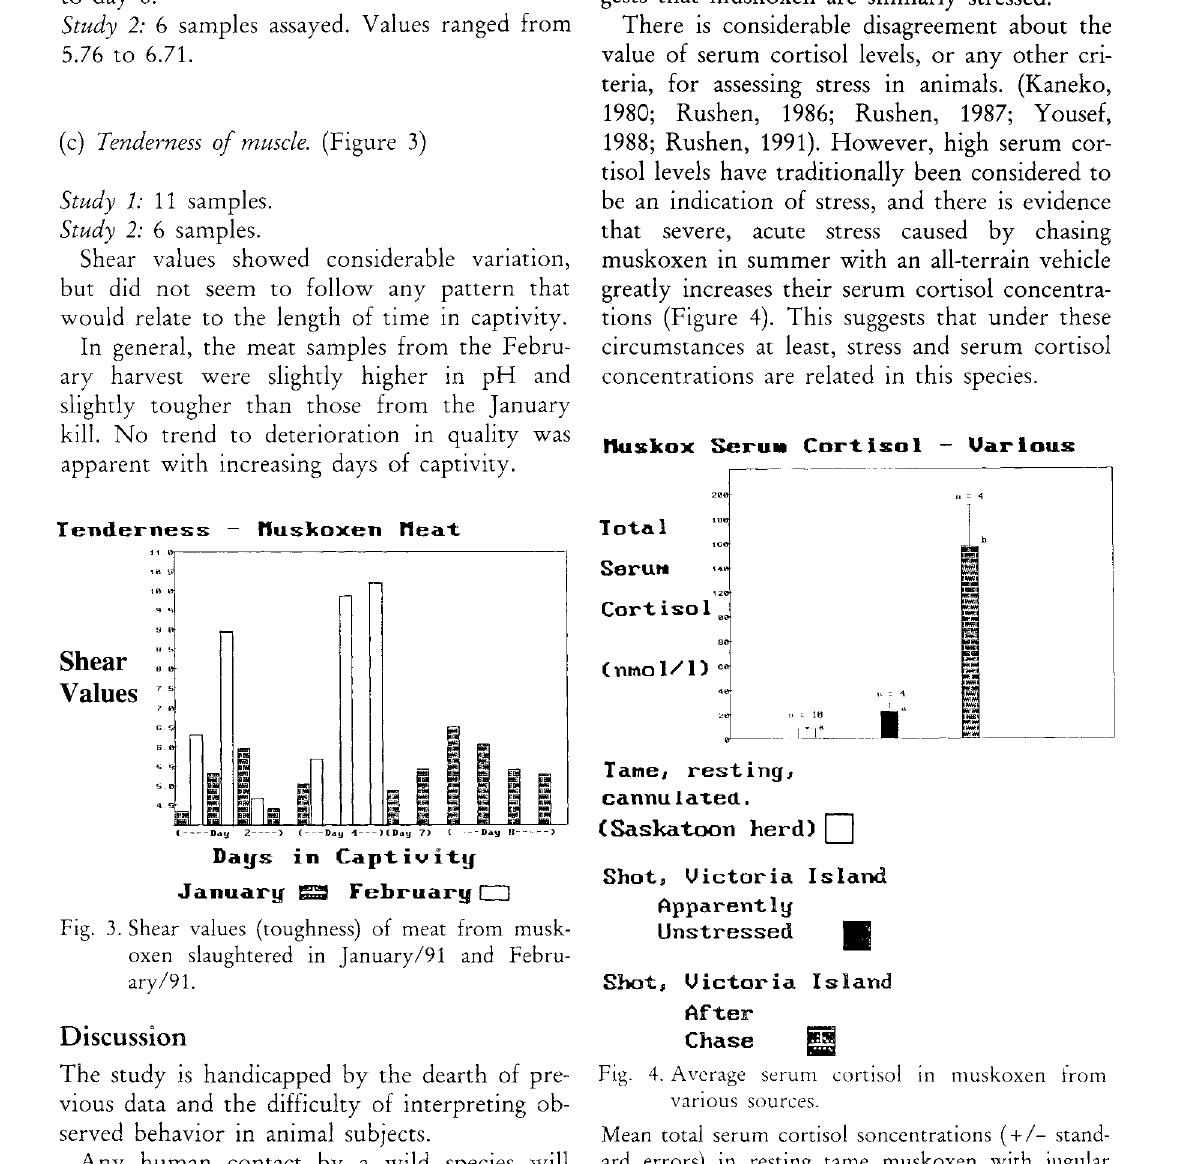
Fig. 4. Average serum Cortisol in muskoxen from various